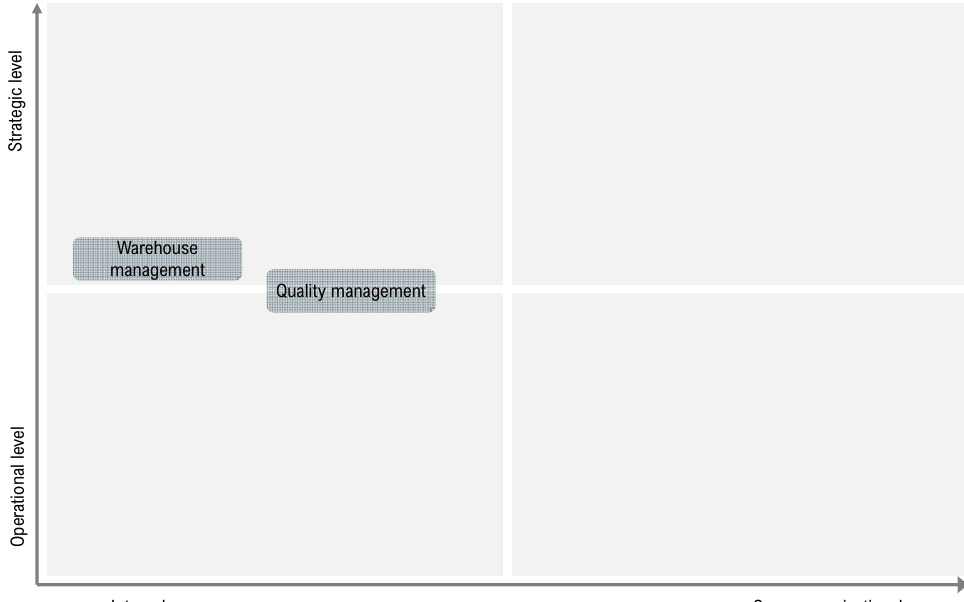
19 of 23 Figure 16. Suggested fields of action for the balanced intermediate profile. 5.4. Advanced Profile